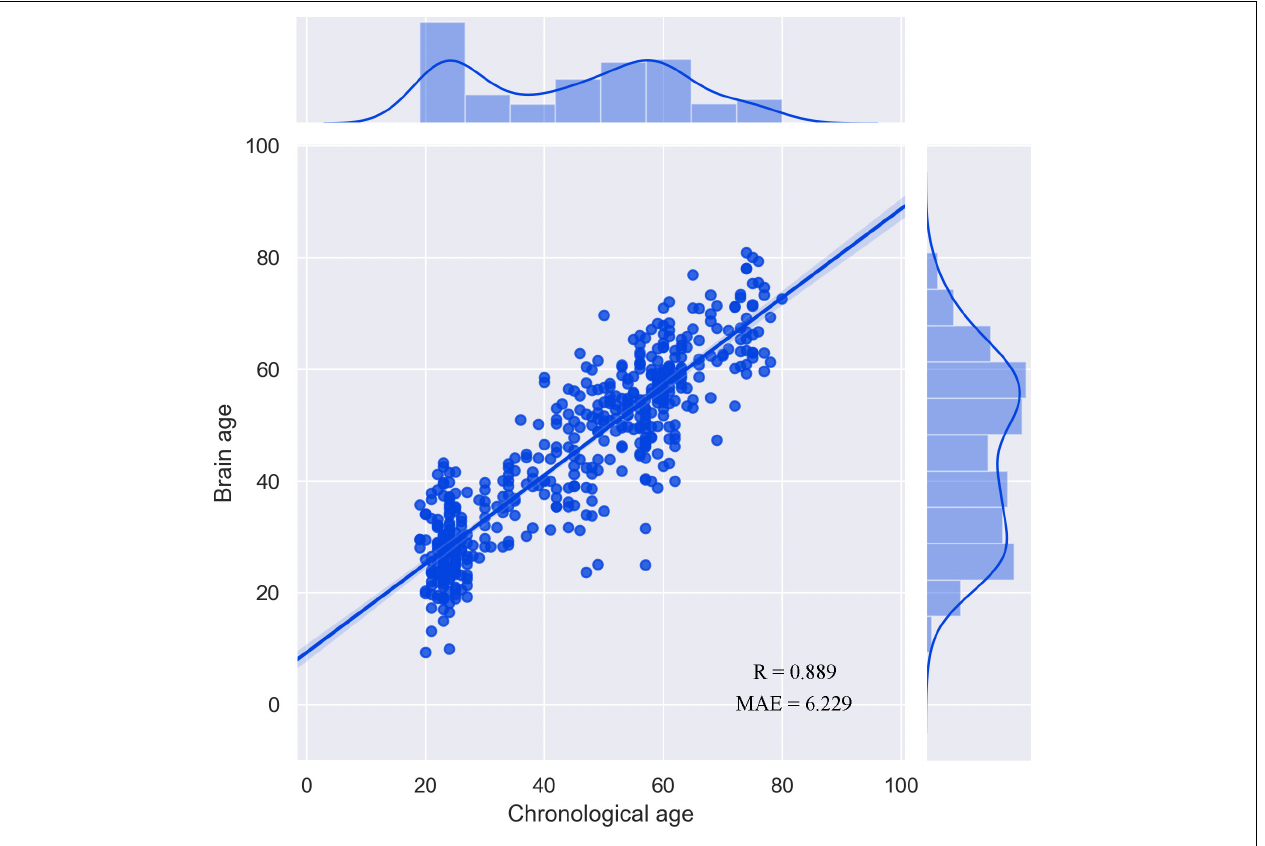
FIGURE 1 | Performance of the prediction